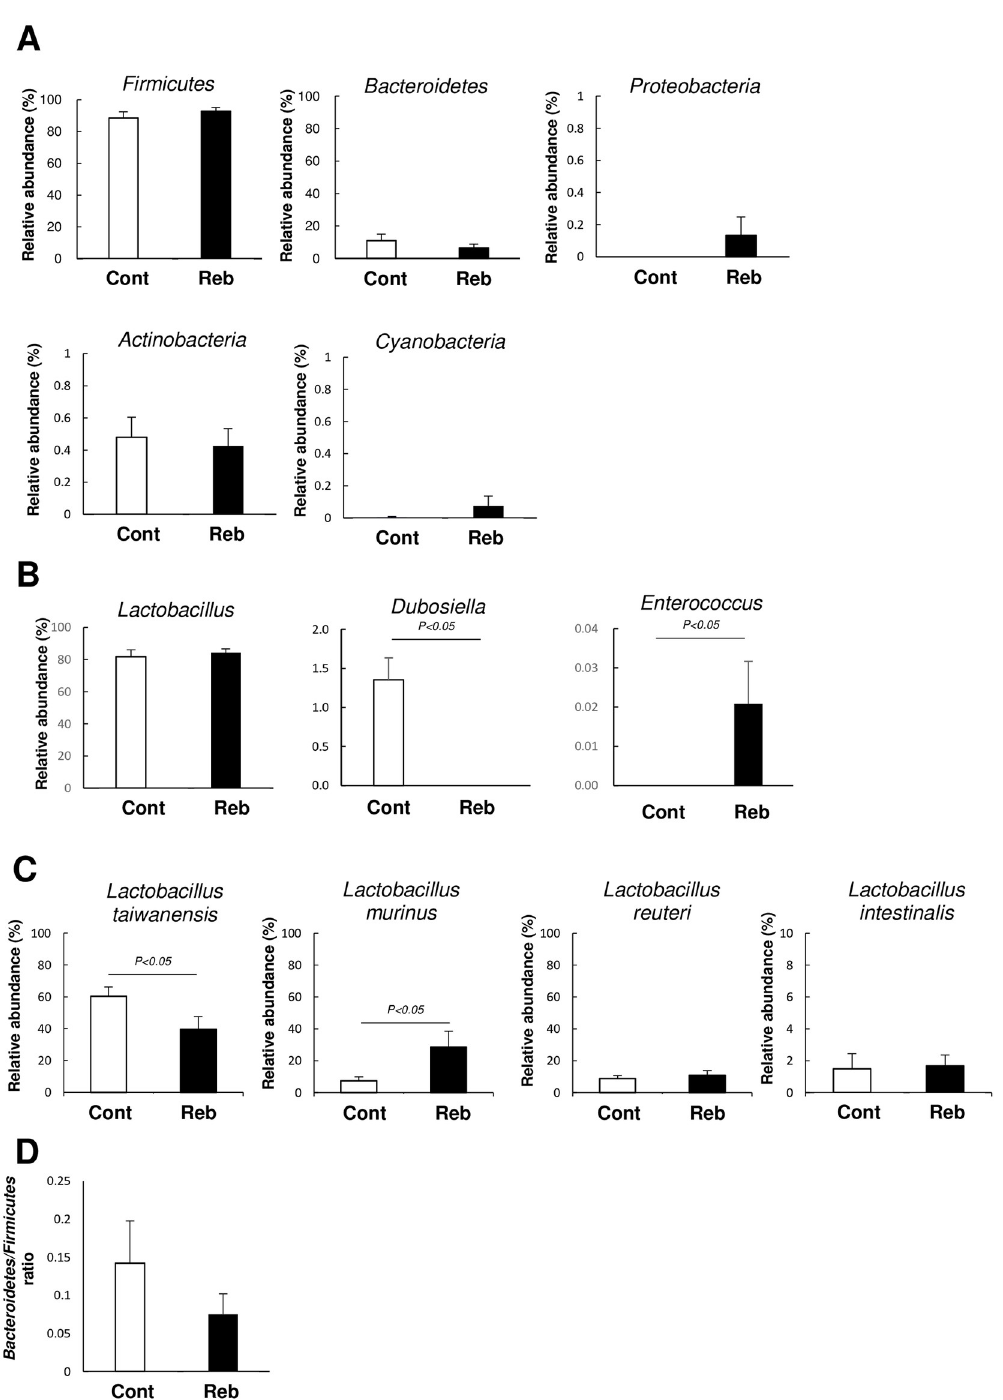
Fig 5. The major bacterial composition of small intestine in mice given rebamipide or vehicle at (A) phylum level (B) genus level (C) species level. (D) Bacteroidetes to Firmicutes ratio. Cont: control group Reb: rebamipide-treated group. Each column represents the mean ± standard error of the mean (S.E.M.). N = 6–7.